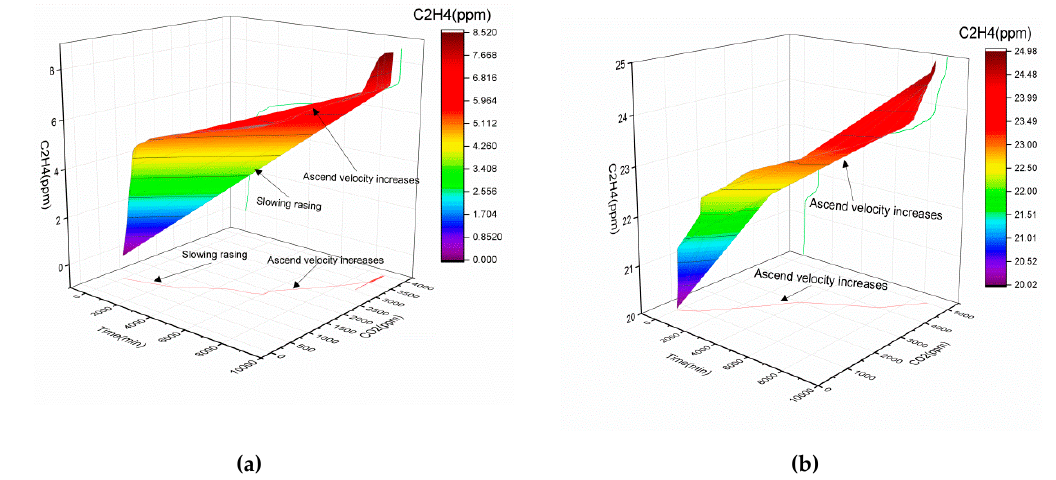
Figure 9. The gas content change of fragrant pears stored in different home storage conditions. (a) The gas content change in refrigeration temperature. (b) The gas content change in room temperature.